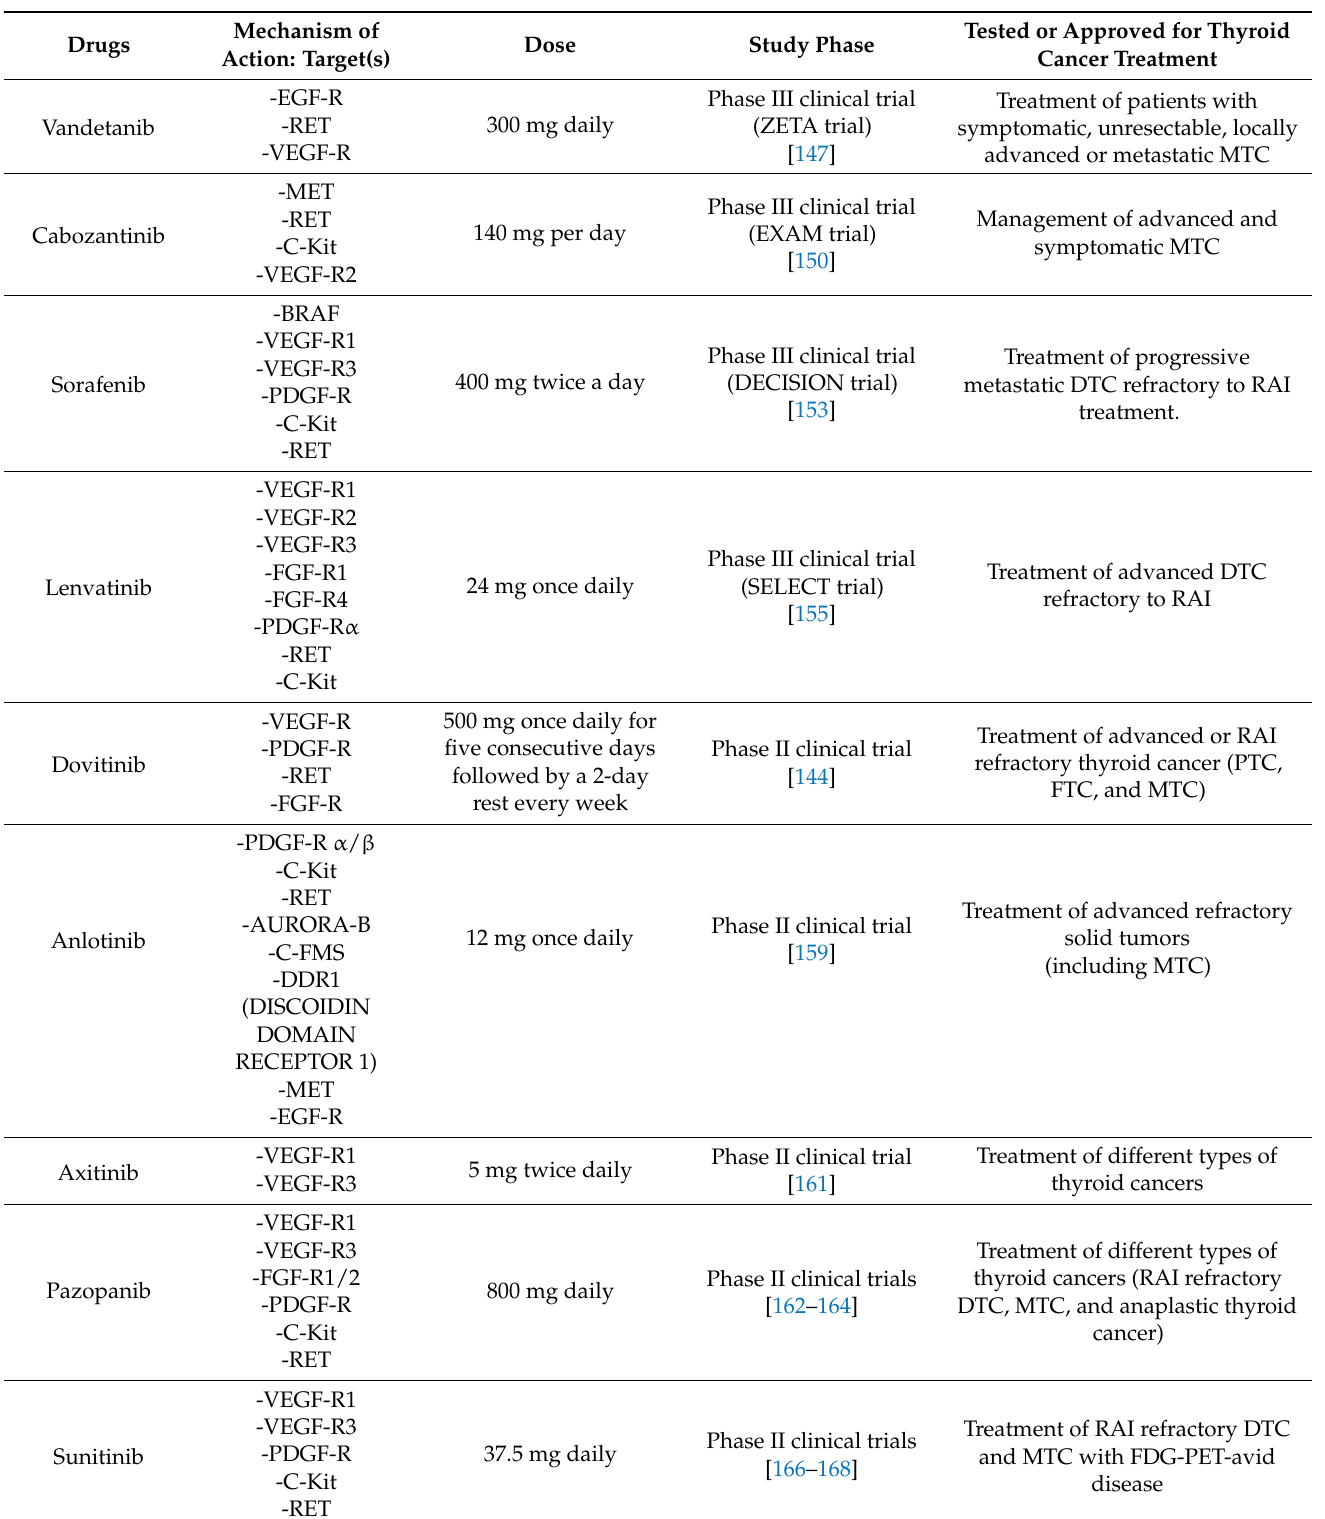
Table 1. Drugs studied in treatment of thyroid cancer: Tyrosine kinase inhibitors and their multitarget activity.